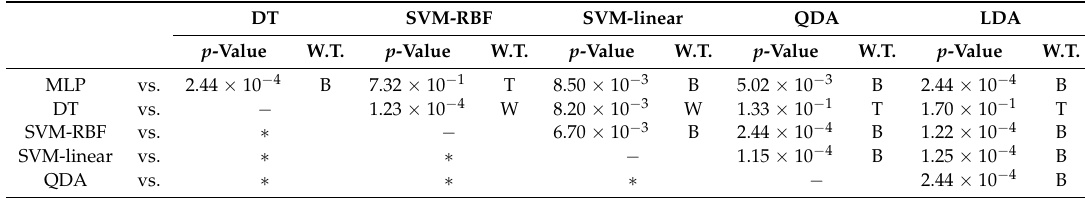
Table 7. Comparison of classification performance using Wilcoxon signed-rank tests (W.T.) at a 5% significance level. B or W indicates that the row method performs better or worse than the column method, respectively, while T shows that they tie with similar performance. ∗ indicates that the lower triangular half of the table is equal to its upper triangular half. These results are obtained using all the data from Table